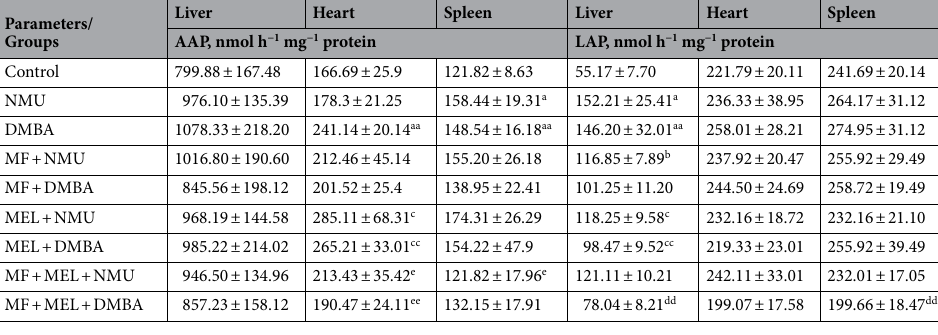
Table 1. Effect of melatonin and metformin on alanyl- and leucyl aminopeptidase activity (nmol h −1 mg −1 protein) in the liver, heart, and spleen in female Sprague-Dawley rats subjected to a high-fat diet in the mammary carcinogenesis model induced by N -methyl- N -nitrosourea (NMU) or dimethylbenzanthracene (DMBA). Metformin (MF) or melatonin (MEL) was administered alone and in combination (MF + MEL). Note. Data are expressed as means ± S.D. Significant differences P < 0.05 are designated as follows: a— NMU group vs. control group; aa—DMBA group vs. control group; b—MF + NMU vs. NMU group; bb—MF + DMBA vs. DMBA group; c—MEL + NMU vs. NMU group; cc—MEL + DMBA vs. DMBA group; d—MEL + MF + NMU vs. MF + NMU group; dd—MEL + MF + DMBA vs. MF + DMBA group; e—MEL + MF + NMU vs. MEL + NMU group; ee—MEL + MF + DMBA vs. MEL + DMBA group. AAP, alanyl aminopeptidase; LAP, leucyl aminopeptidase. NMU, N -methyl- N -nitrosourea; DMBA, dimethylbenzanthracene; MF, metformin; MEL,